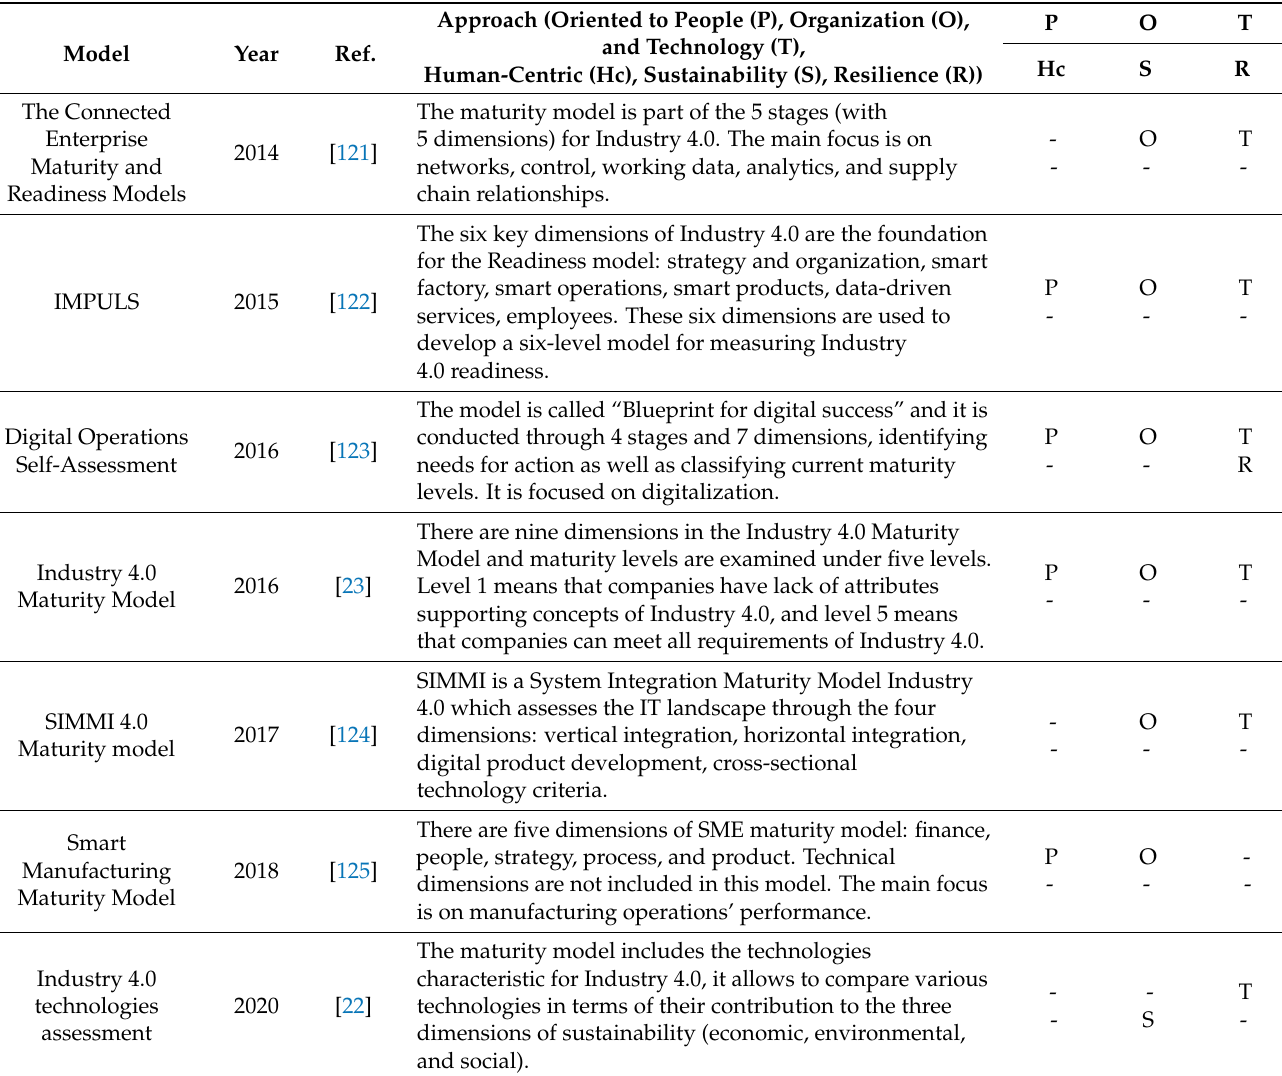
Table 2. A brief review of some of the existing maturity and readiness